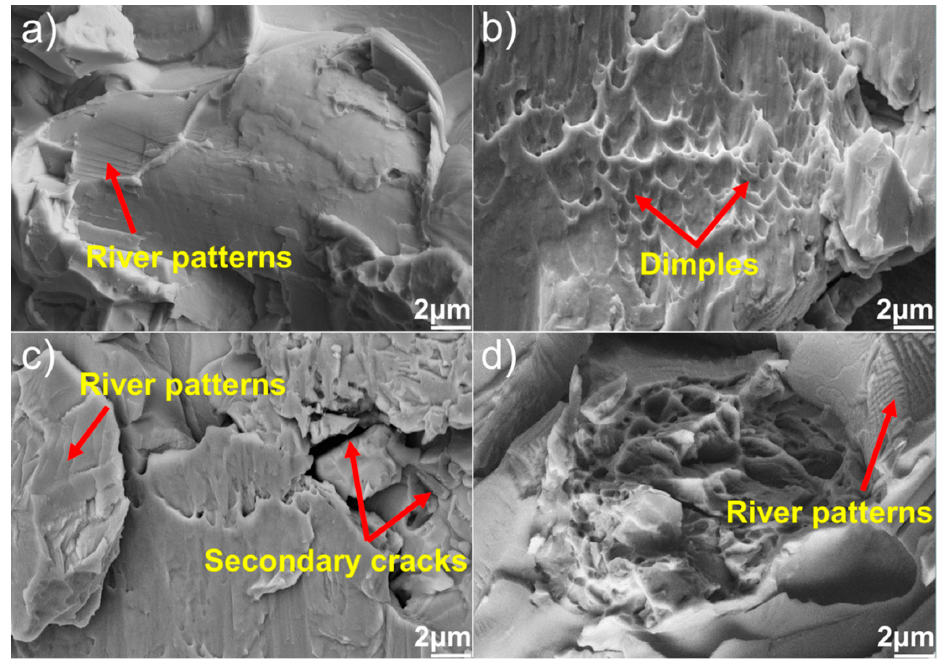
Figure 12. Fracture morphologies of DD98M-DD98M joints brazed at 1060 ° C for different soaking times: ( a ) 10 min, ( b ) 30 min, ( c ) 60 min, and ( d ) 90 min. times: ( a ) 10 min, ( b ) 30 min, ( c ) 60 min, and ( d ) 90